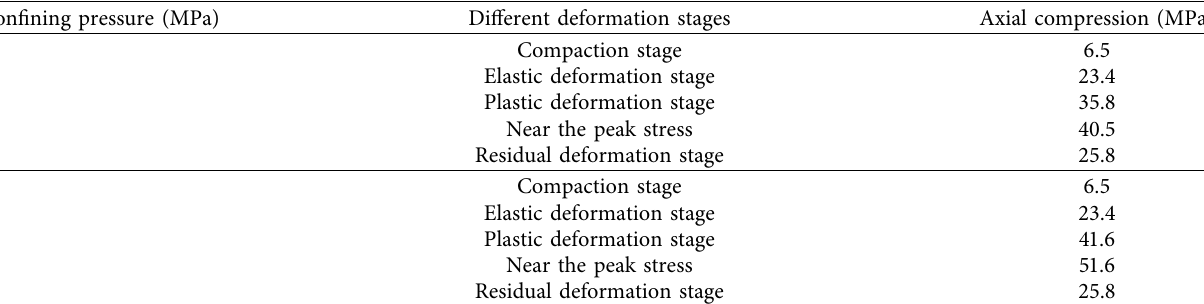
Table 3: Axial compression design at different deformation